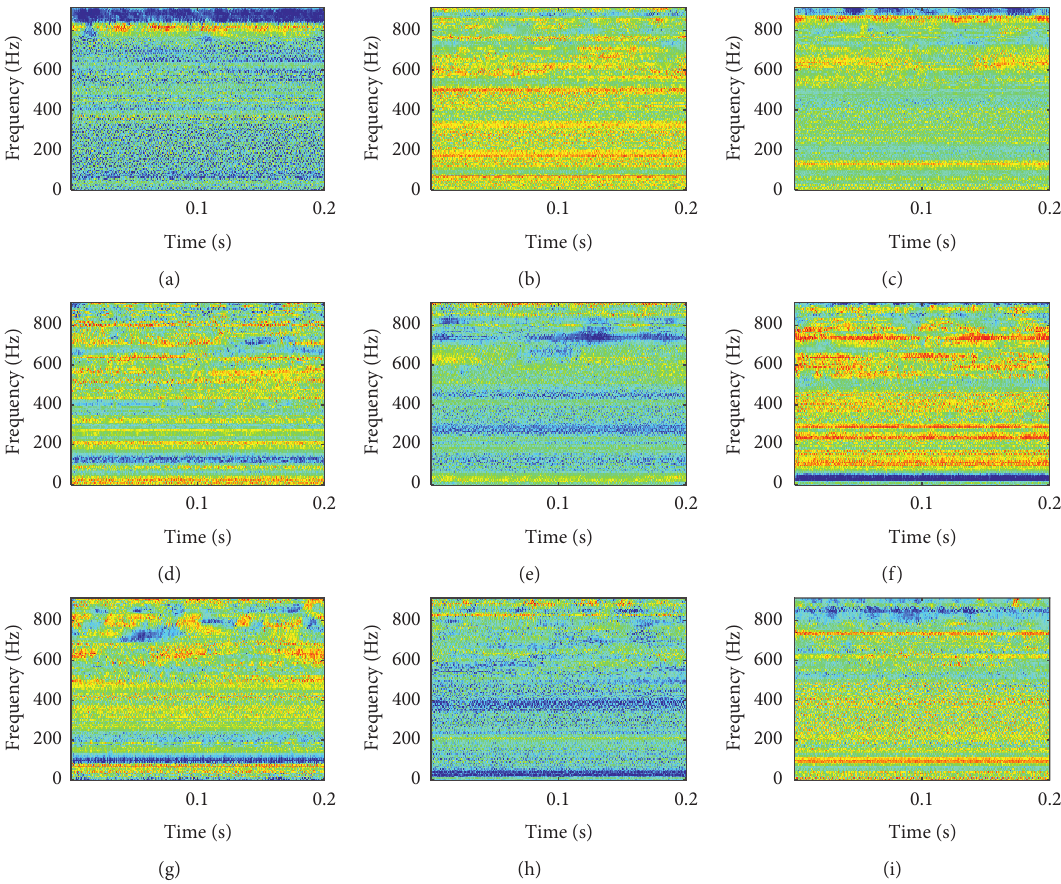
Figure 12: Feature maps for eight fault-states and one normal state extracted from the final convolutional layer of the trained CNN network. (a) Fault no. 1. (b) Fault no. 2. (c) Fault no. 3. (d) Fault no. 4. (e) Fault no. 5. (f) Fault no. 6. (g) Fault no. 7. (h) Fault no. 8. (i)